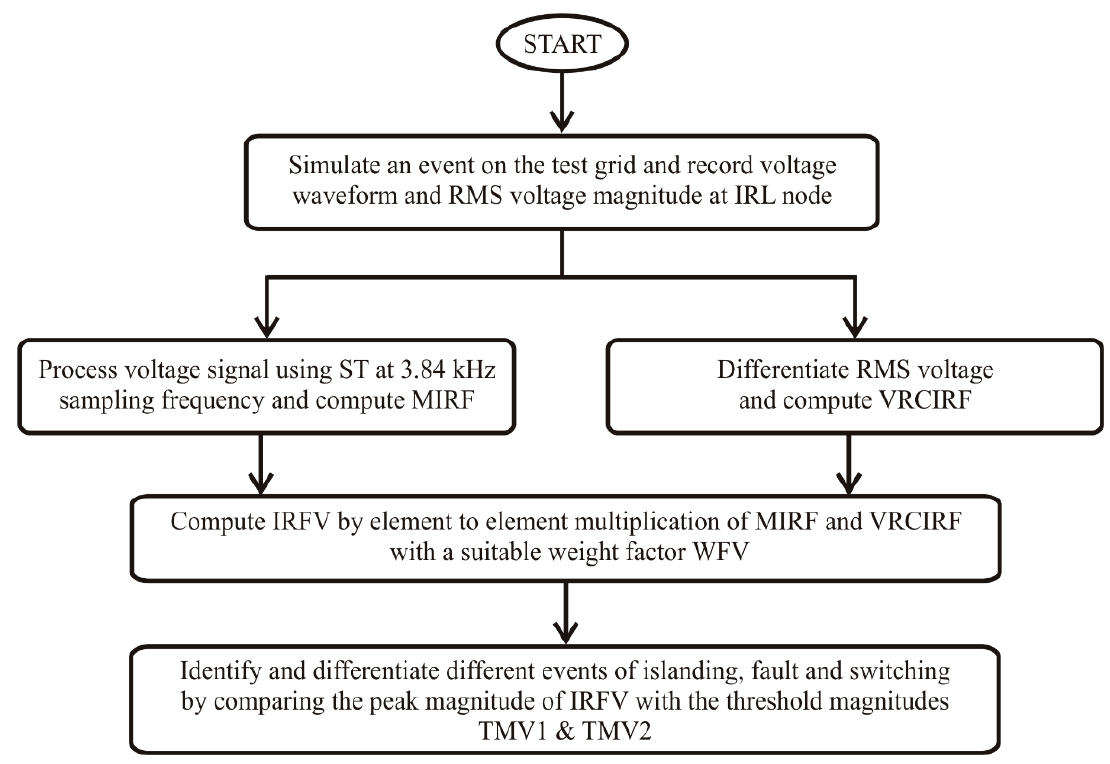
Figure 2. Proposed voltage-based algorithm for identification of islanding events.